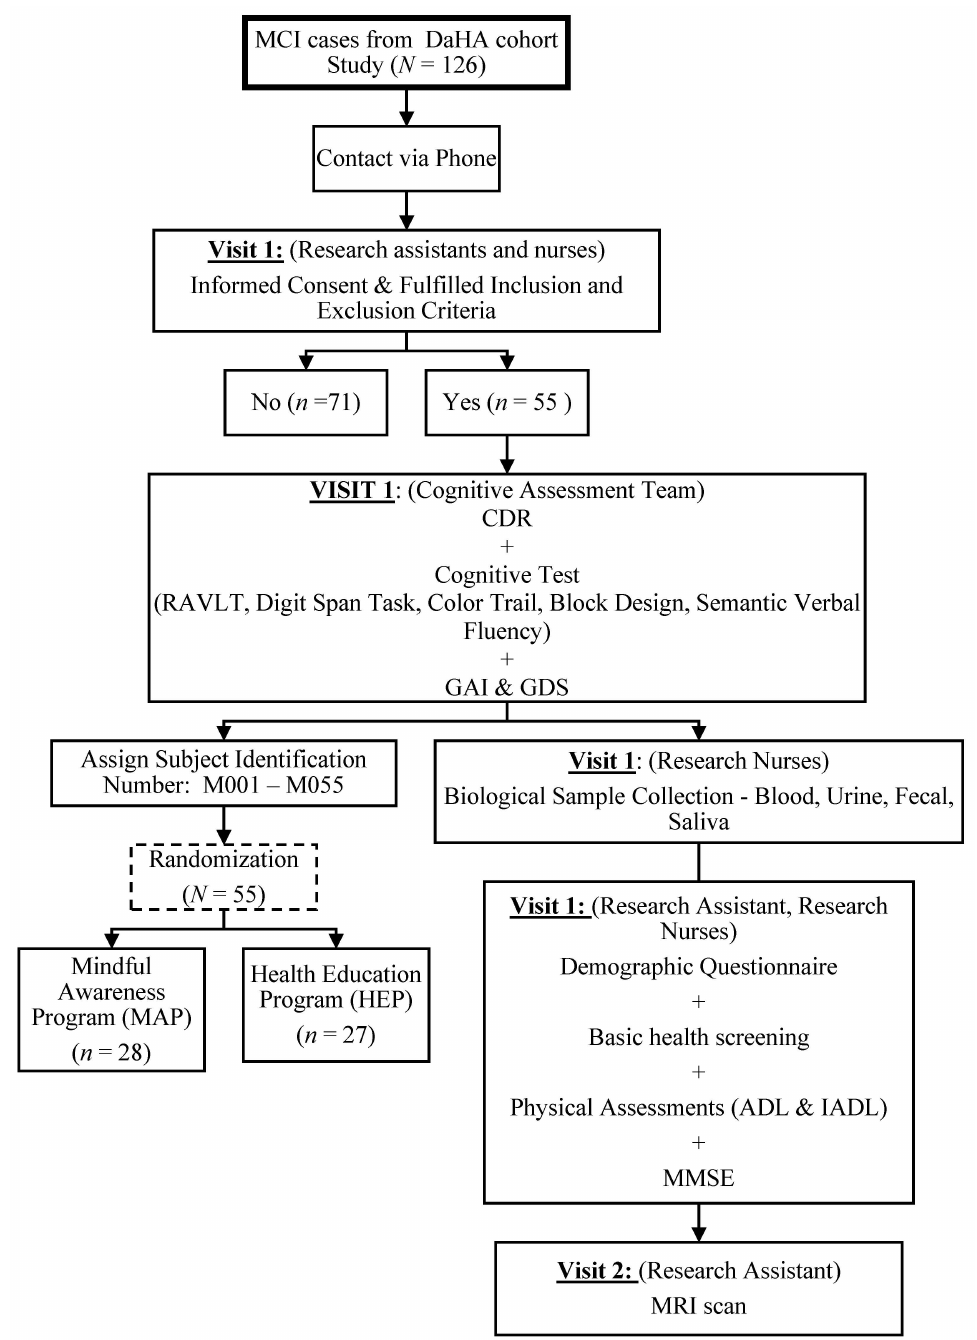
Figure 1. Protocol for Participant Screening, Recruitment, and Baseline Assessments. MCI = mild cognitive impairment; DaHA = Diet and Healthy Aging Study; CDR = clinical dementia rating; RAVLT = Rey Auditory Verbal Learning Test; GDS=Geriatric Depression Scale; GAI = Geriatric Anxiety Inventory; ADL = Activities of Daily Living; IADL = Instrumental Activities of Daily Living; MMSE = Mini-Mental State Examination; MRI = Magnetic Resonance